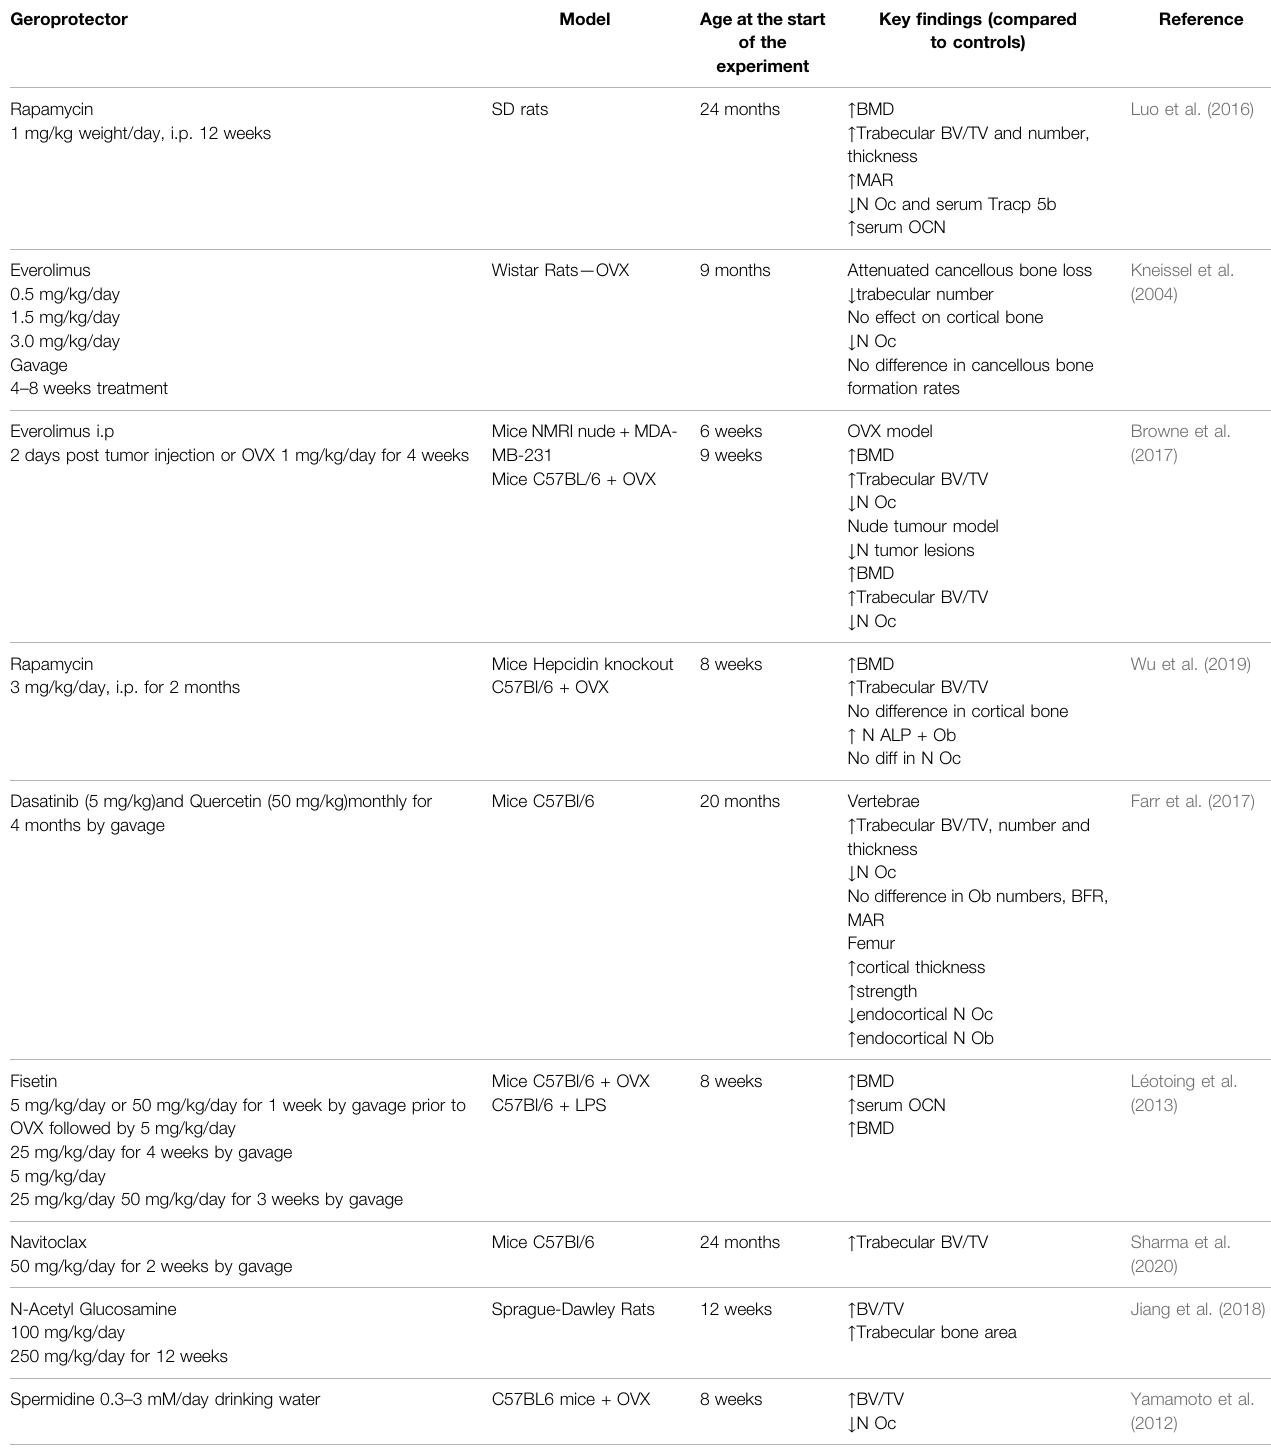
TABLE 2 | Summary of in vivo testing of geroprotectors to attenuate bone loss in experimental models. Geroprotector Model Age at the start